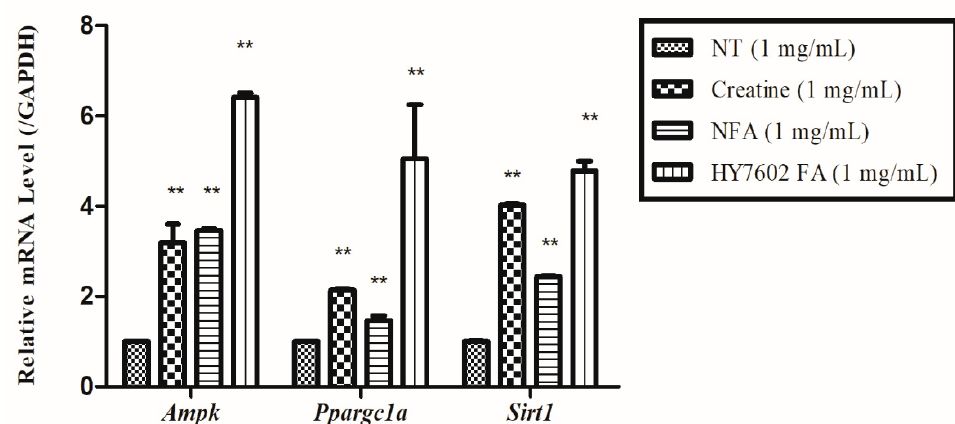
Figure 3. Intestinal effects of fermented antler (FA) on AMPK signal pathway-related genes ( Ampk, Ppargc1a, Sirt1 ) asso-